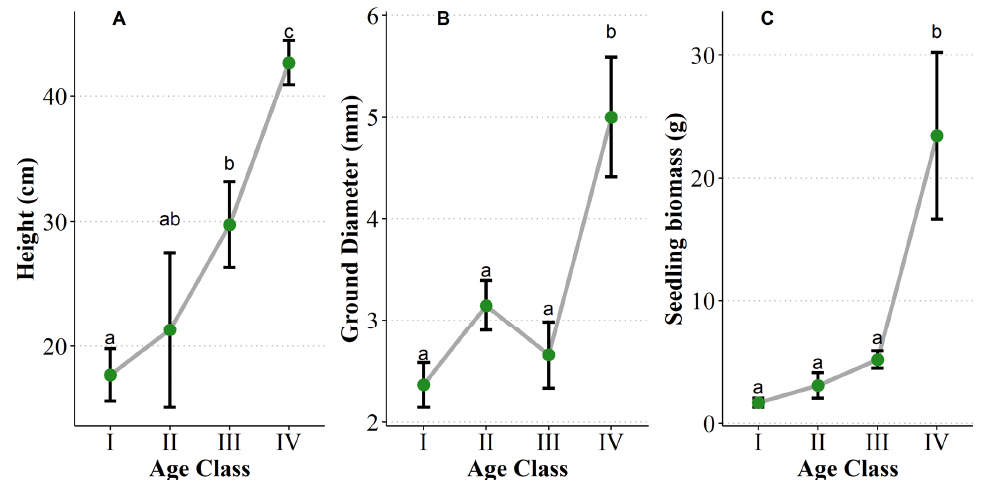
Figure 4. Changes of seedling biomass ( A ), ground diameter ( B ), and seedling biomass ( C ) with the increase of seedling age of Quercus acutissima. Different letters above error bars show significant differences.